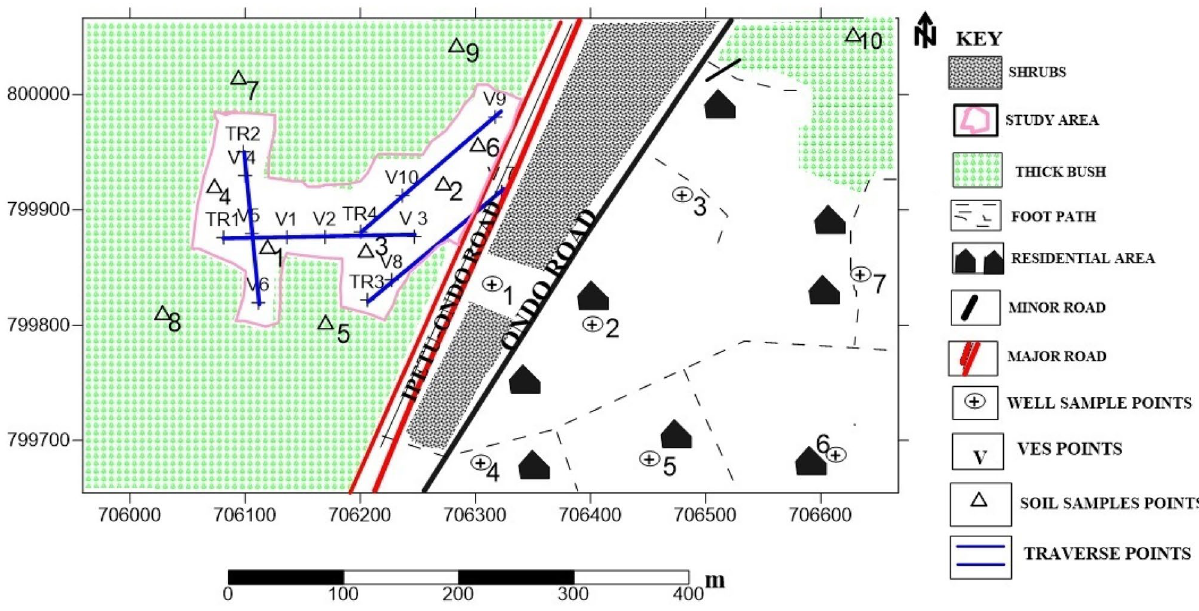
Figure 2. Data Acquisition Map of Oke-Tage Dumpsite.